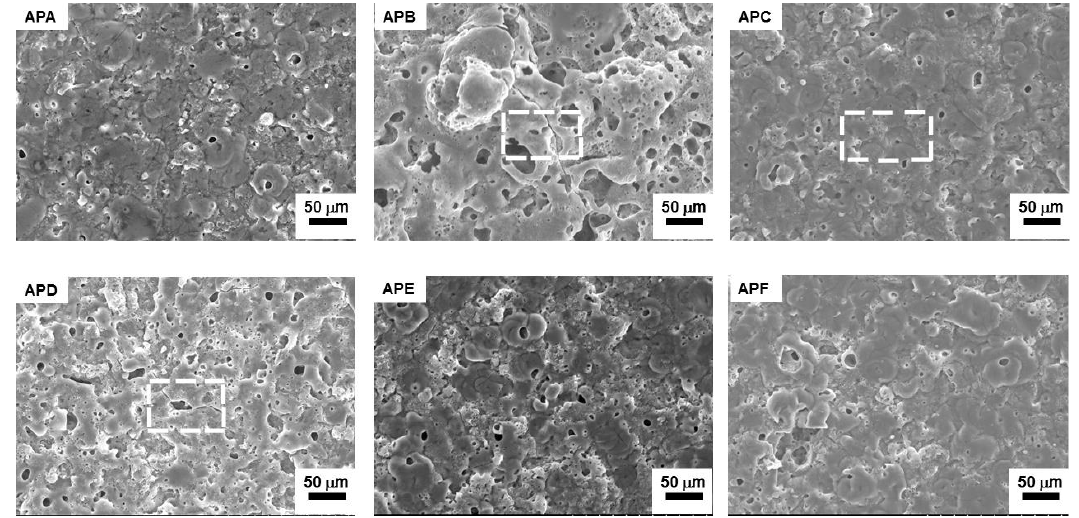
Figure 6. Surface morphologies of PEO samples prepared under different process parameters.